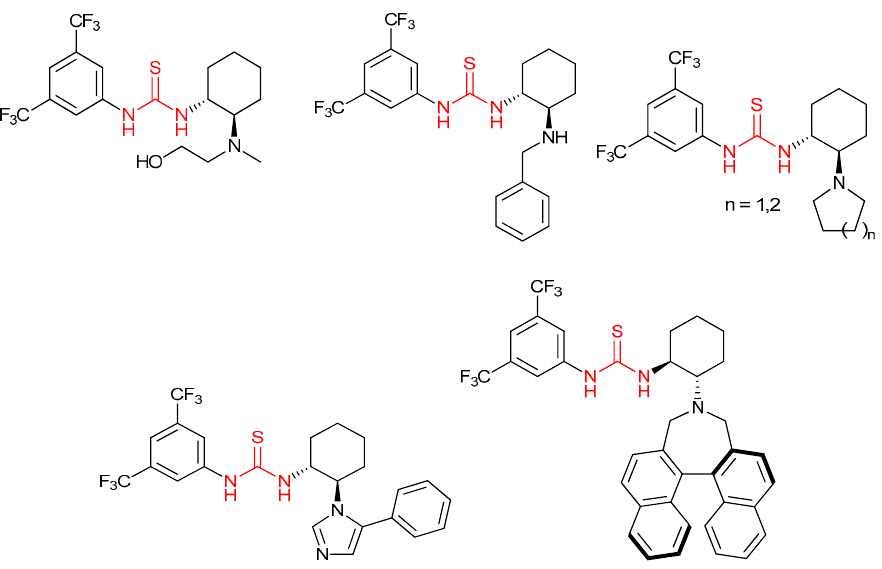
Figure 8. Various chiral DACH-based thioureas used as organocatalysts [153–163].